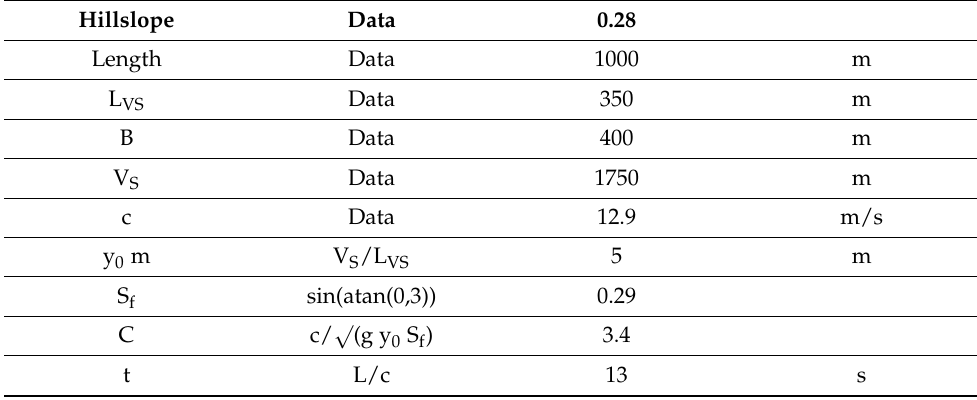
Table 1. The Sölvadalur slide data computed using Equation (11) with the tabulated